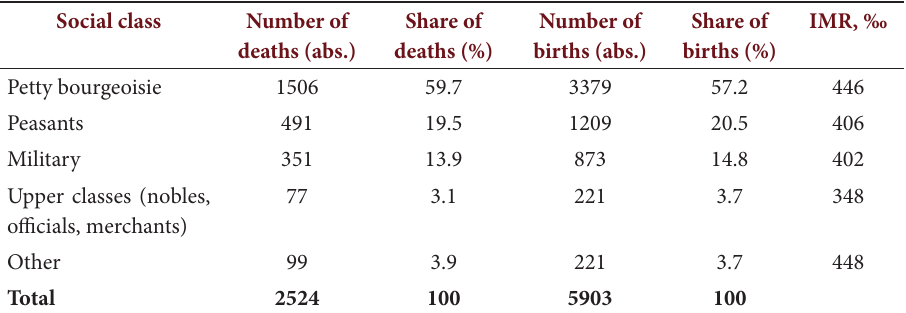
Table 1. Distribution of births and infant deaths, infant mortality rate (IMR) in the Pokrovsky parish by social class,